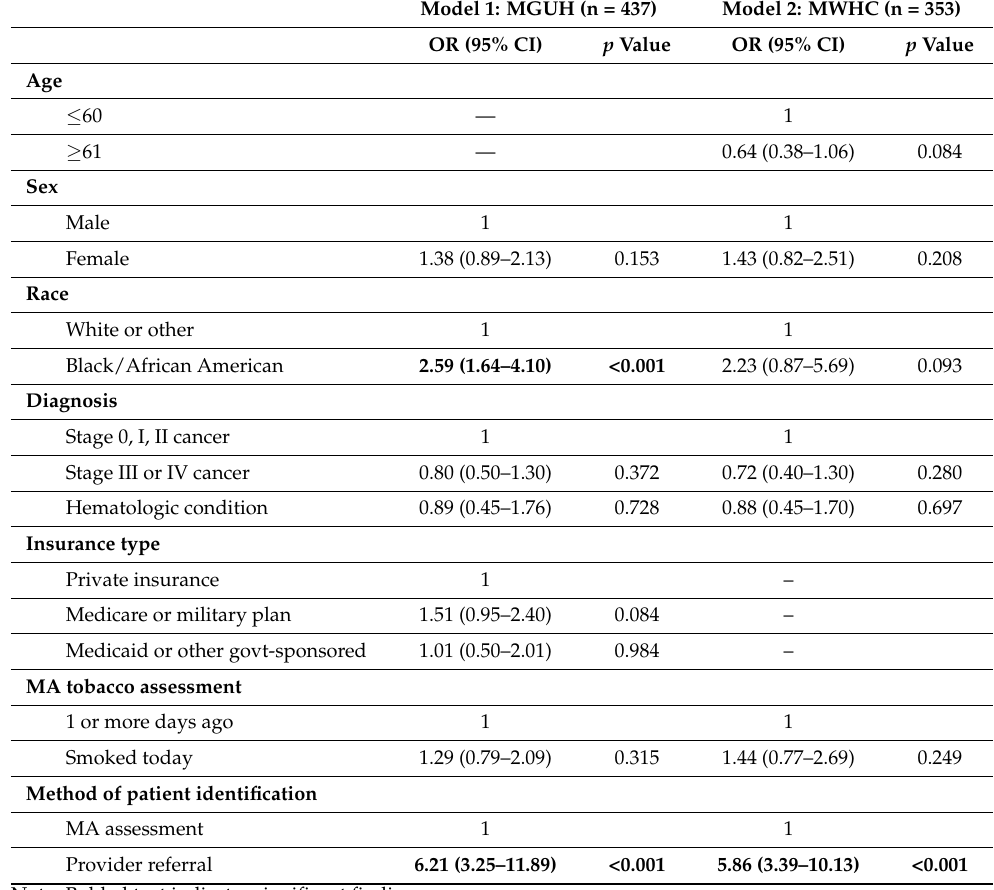
Table 6. Adjusted logistic regression analysis: predicting enrollment in